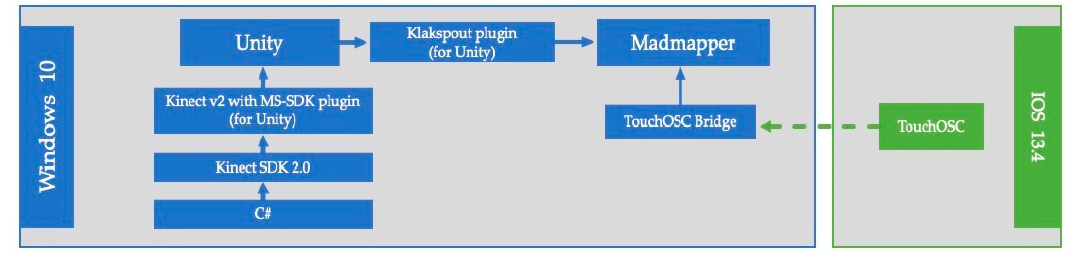
Figure 3. Software used in the study’s prototype.